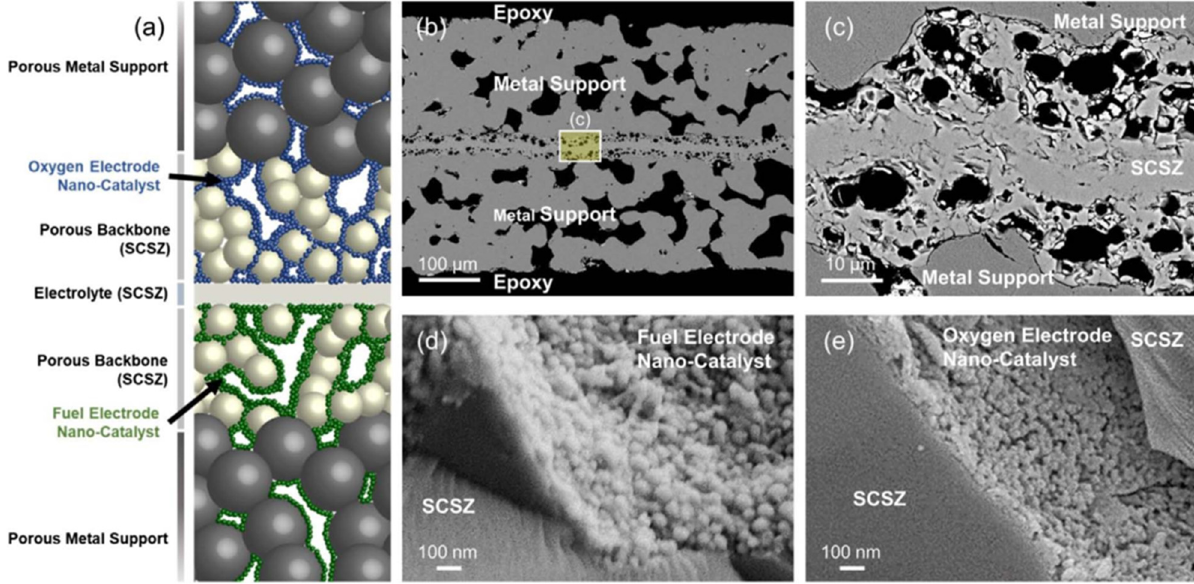
Figure 13. ( a ) Structure diagram of the MSC with infiltrated electrodes. ( b ) SEM micrographs of the cross-section of the MSC showing the “metal-support/SCSZ backbone/SCSZ dense electrolyte/SCSZ backbone/metal-support” symmetric structure. ( c ) Cross-section of porous backbones and dense electrolyte. ( d ) Hydrogen electrode catalyst (Ni-SDC) infiltrated on SCSZ backbone ( e ) Oxygen electrode catalyst (Pr 6 O 11 ) infiltrated on SCSZ backbone. Reproduced with permission from Ref [118].